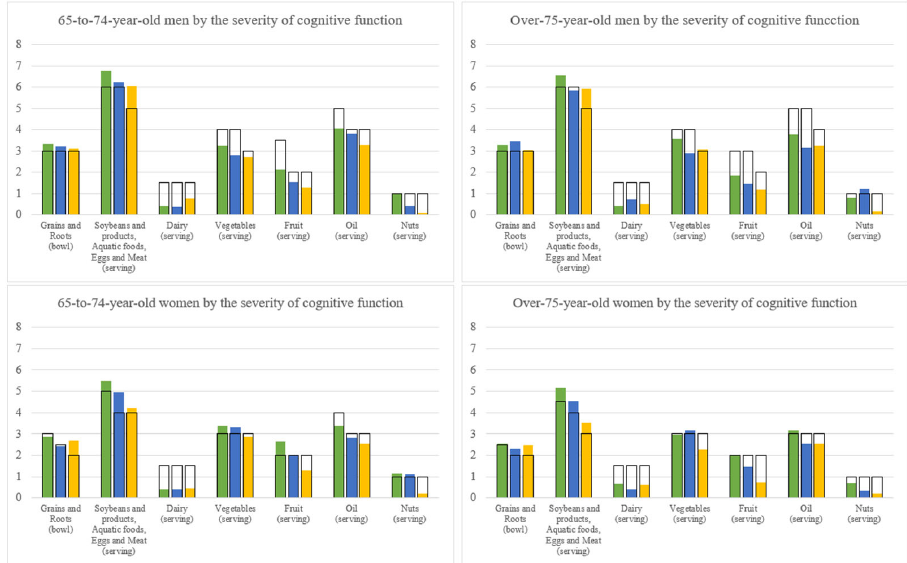
Figure 4. Comparing dietary intake levels of the six food groups with the Daily Food Guide of Tai ‐ wan among the severity groups of cognitive function by sex and age groups. Top: The dietary in ‐ takes of the six food groups by three cognitive impairment (CI) subgroups and by two age groups in men. Bottom: The dietary intakes of the six food groups by three CI subgroups (the robust is in green, the pre ‐ frail is in blue, and the frail is in yellow) and by two age groups in women. The normal cognitive function is in green, the mild CI is in blue, and the CI is in yellow. The blank bar ( □ ) is the recommended number of servings of the six major food groups by the Daily Food Guide of Taiwan according to the corresponding energy levels.